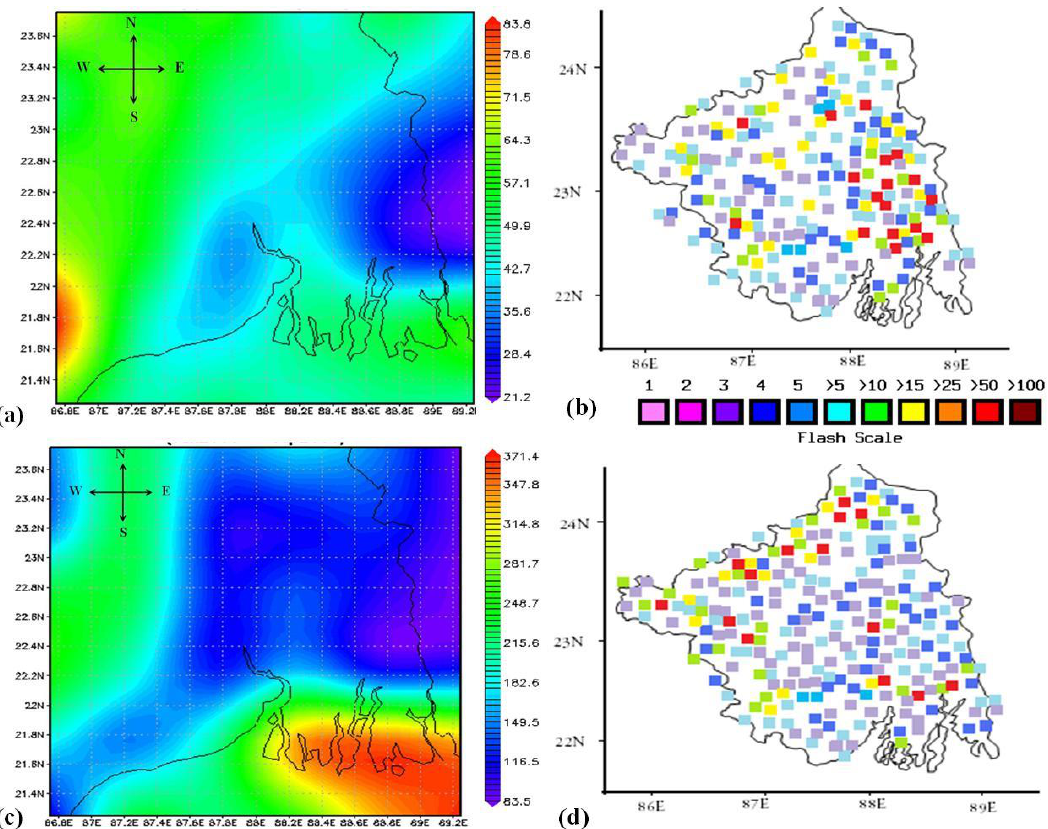
Figure 4. Comparison of flash count with AOD. ( a ) Variation in total number of flashes along with AOD over the years (2004–2011) and ( b ) their scatter plot during pre-monsoon months. ( c ) Monsoon period variation in total flashes and AOD and ( d ) their scatter plot. Crosshairs represent first standard deviation of the parameters.